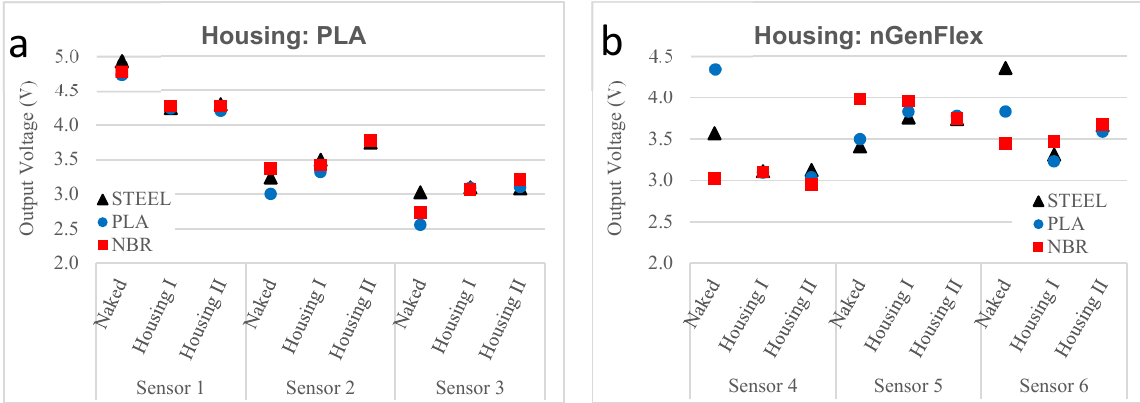
Figure 4. ( a ) Response of the sensors to a 40 kg load when tested with pucks of different materials (Steel, PLA, NBR) in the different conditions (Naked, Housing I, Housing II) for housing made of PLA; ( b ) for housing made of nGen_Flex. Note the larger variability of the measurements in the naked condition.